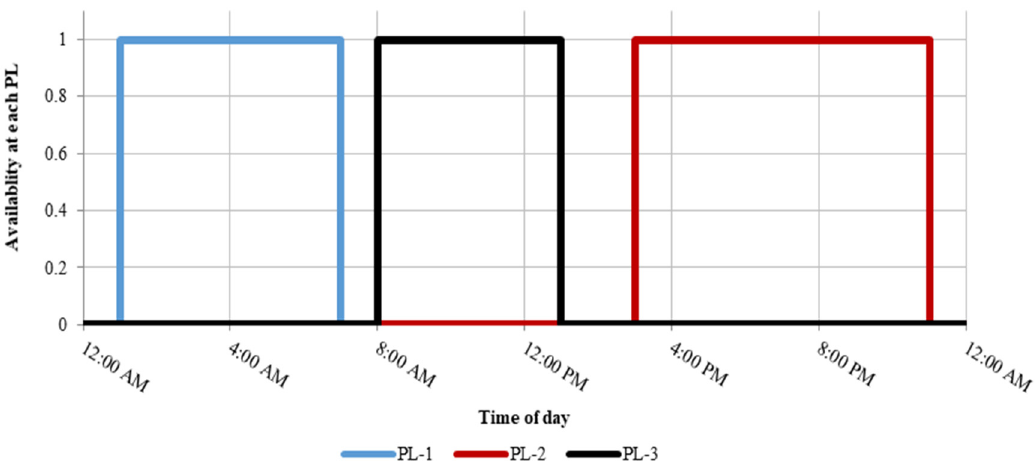
Figure 6. Availability of the MESS at each PL.